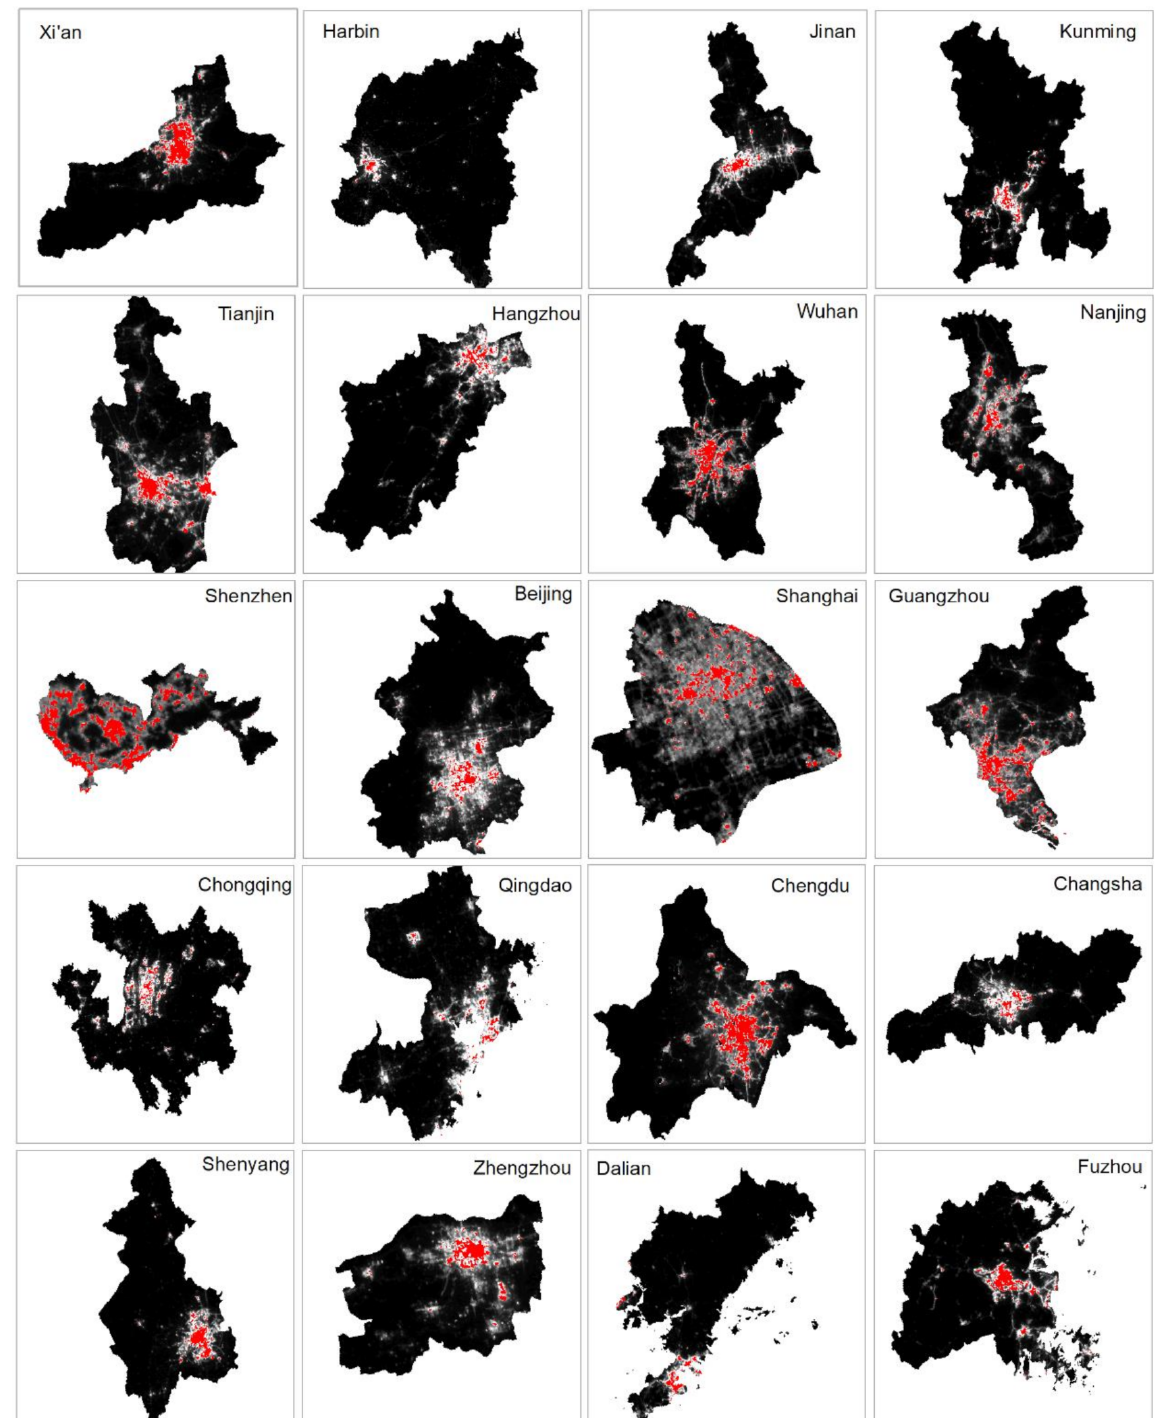
Figure 4. (Color online) Urban hotspots based on NTL imagery using the third mean value as the cutoff